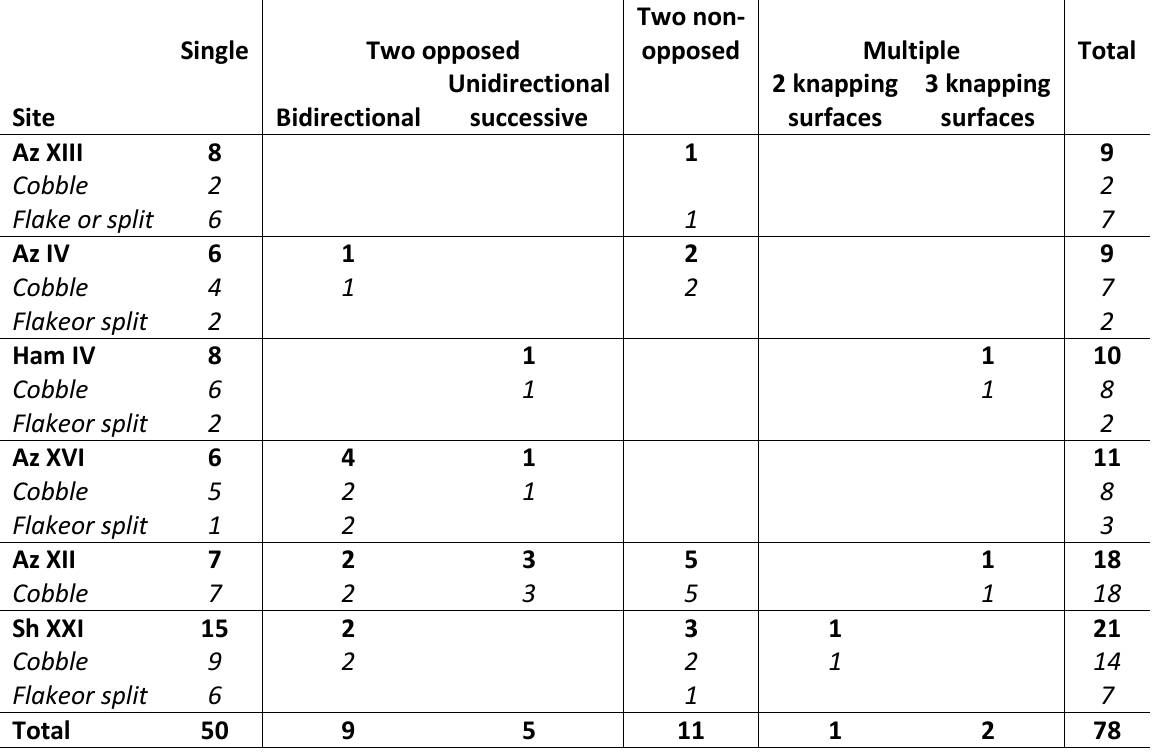
Table 4. Characteristics of platform cores from sites studied. Single Two opposed Site Bidirectional